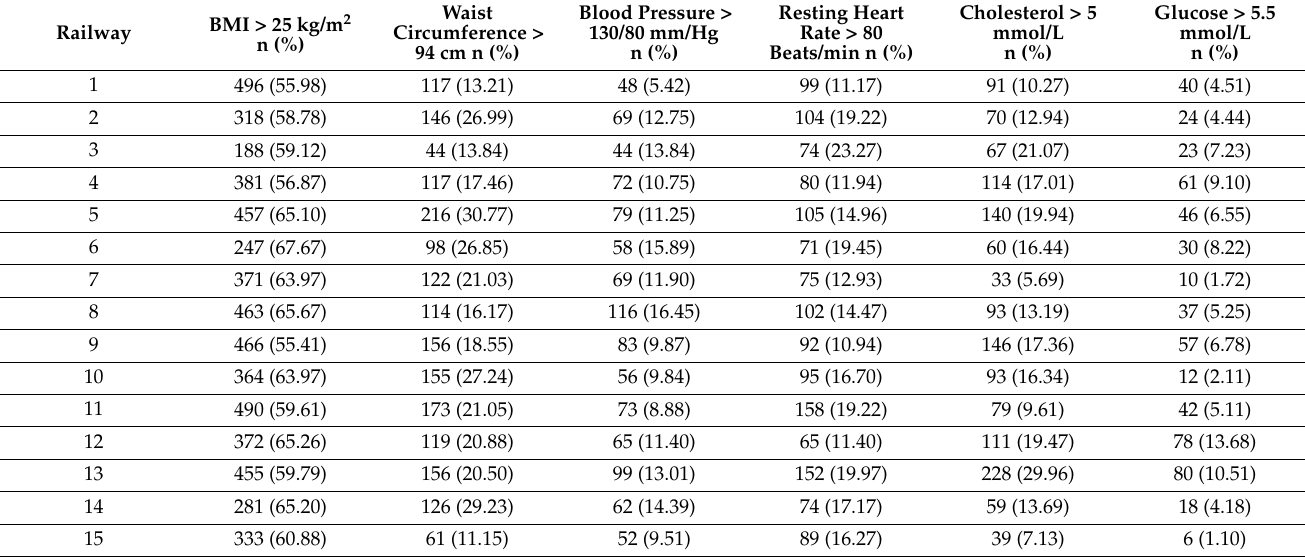
Table 3. Measured individual health conditions by railway.